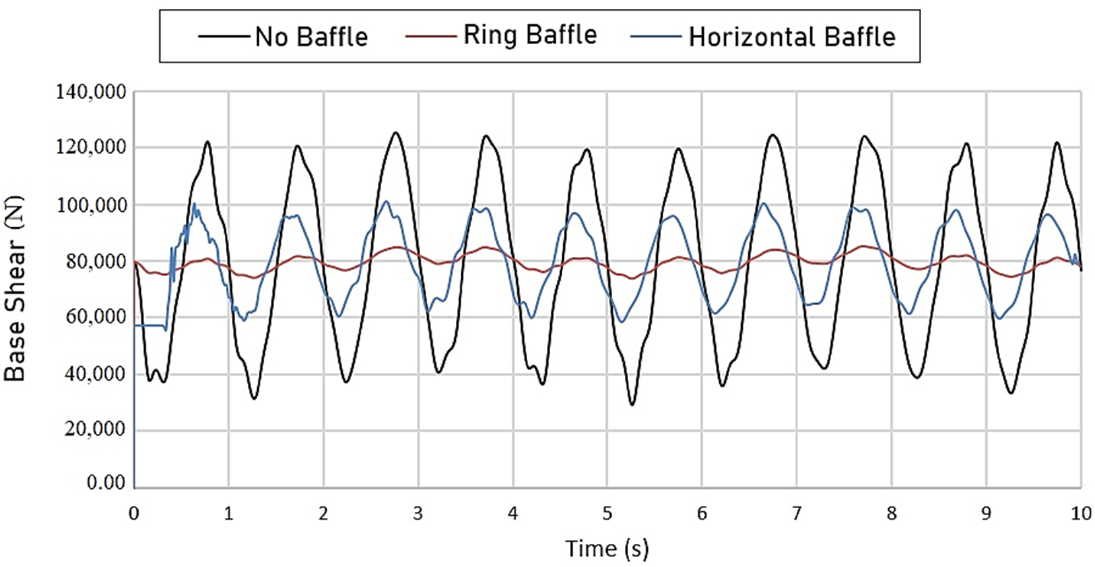
Figure 16. The maximum base shear (horizontal baffle, annular, and no baffle) in a rigid elevated storage tank.